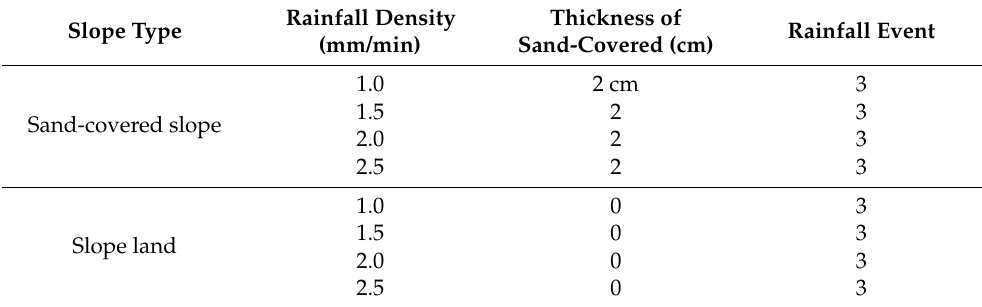
Table 2. Design scheme of indoor rain test.